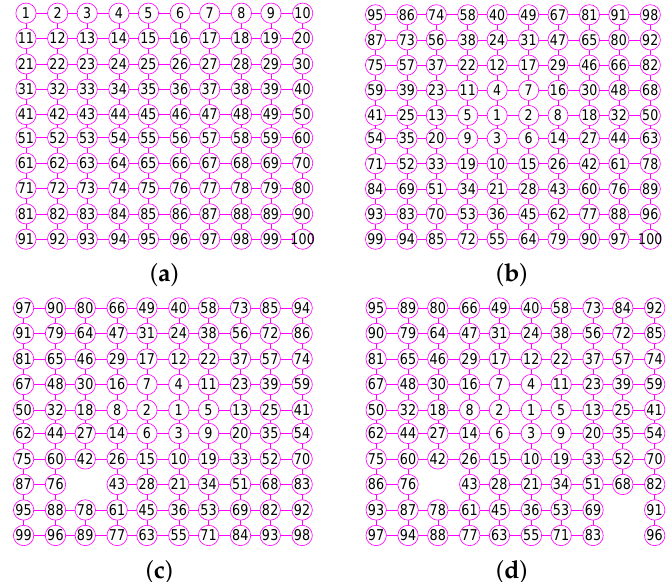
Figure 7. The TopMost graphs of three graphs, including the 10 × 10 grid graph G 10,10 , G 10,10 − u , G 10,10 − u − v − w with u = 73, v = 88, w = 97 ∈ V ( G 10,10 ) . ( a ) A 10 × 10 grid graph G 10,10 of 100 vertices and 180 edges; ( b ) The TopMost graph of G 10,10 ; ( c ) The TopMost graph of G 10,10 − u ; ( d ) The TopMost graph of G 10,10 − u − v − w .